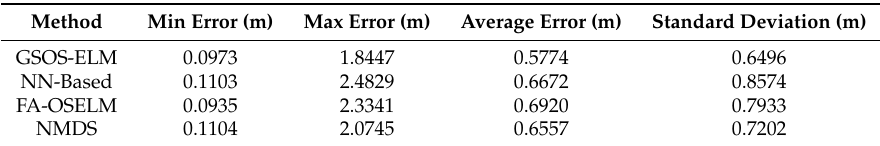
Table 4. Comparison Result under Simulation Environment.